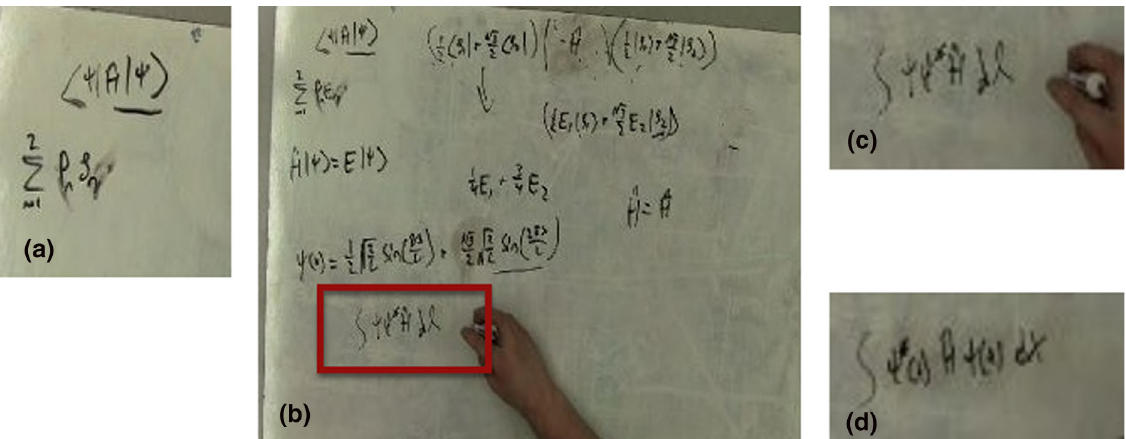
FIG. 5. (a) Beginning of discussion when student describes calculating the expectation value as a weighted average. (b) Full board when the student makes an initial attempt at writing the integral for calculating the energy expectation value (boxed in red). (c) Detail of initial expectation value integral with incorrect ordering of terms in integrand. (d) Detail of the student ’ s second attempt at writing down the integral, after attending to the Dirac bracket for the expectation